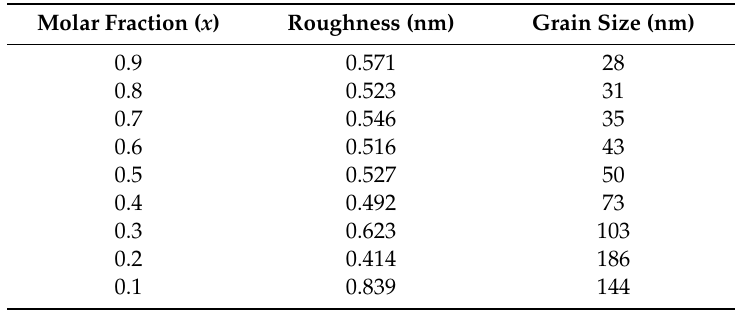
Table 3. Surface roughness and grain size of Zn 1-x Mg x S thin films (0.1 ≤ x ≤ 0.9). Molar Fraction ( x )